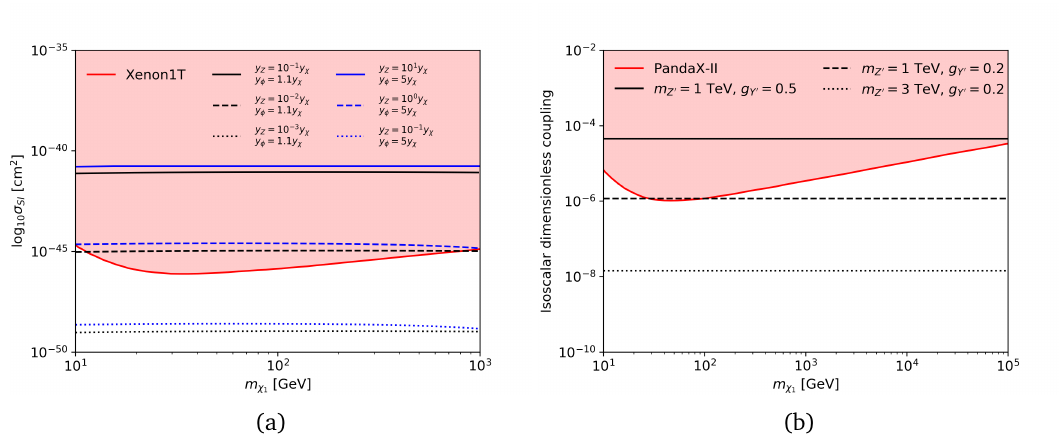
Figure 3: The impact of direct detection constraints on (a) the mixing between χ and the neutral components of the doublets φ = y y , y χ in the legend to indicate that these arise from the coupling to the Z . χ Z R L = v We have set v here, and (b) the mass of the Z (cid:48) and and g S H straints on the O operator (here in the form used in [ 89 ] , where the dimensionless 13 coupling is defined as the squared dimensionless Wilson coefficient when setting the suppression scale to the electroweak